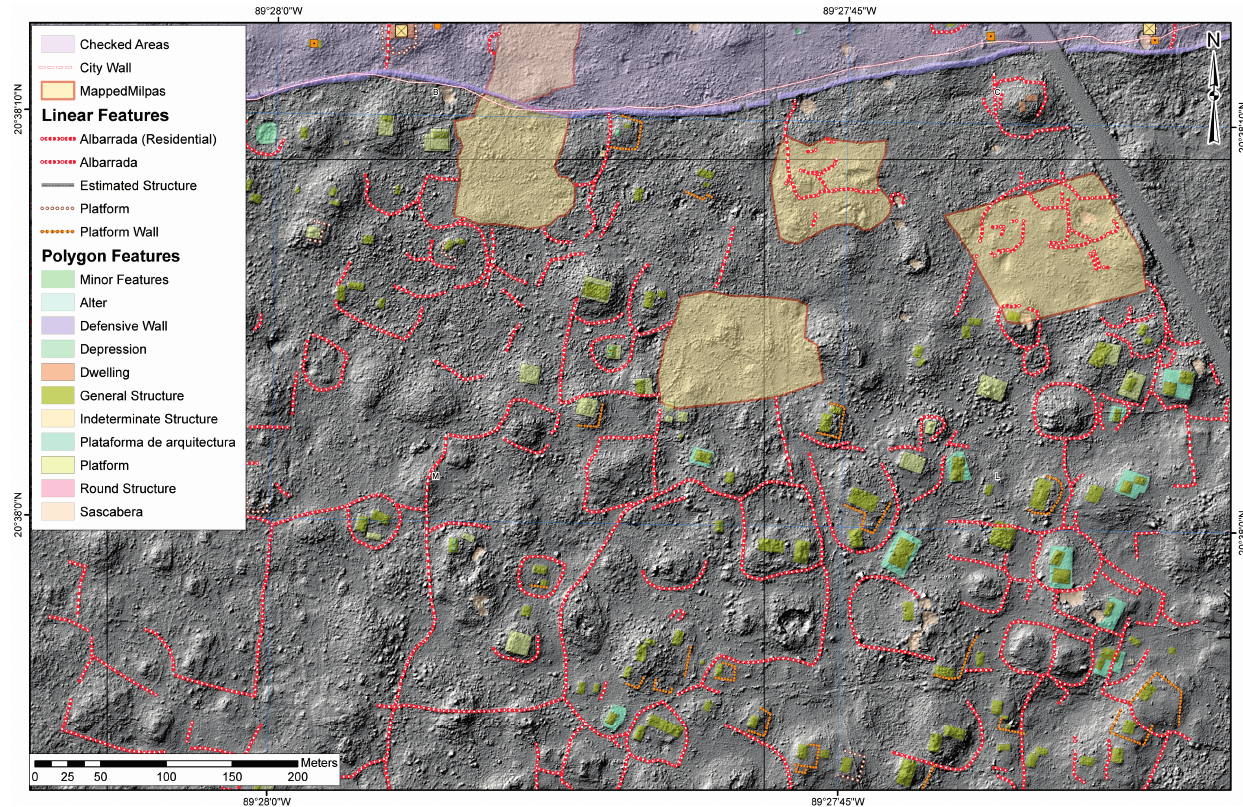
Figure 10. Example map of urban settlement within the city